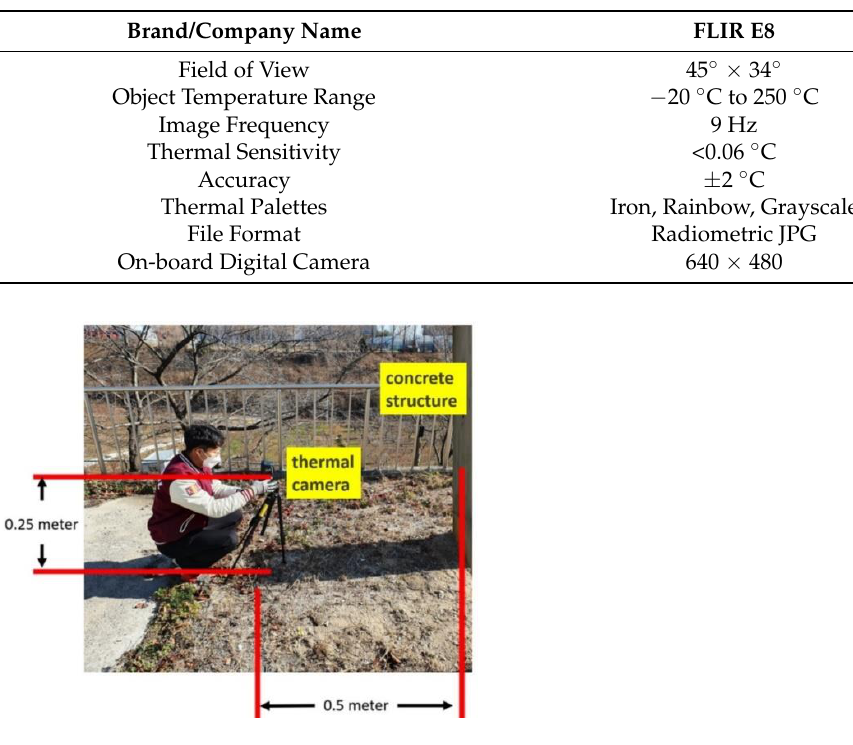
Table 1. Thermal camera technical specifications.